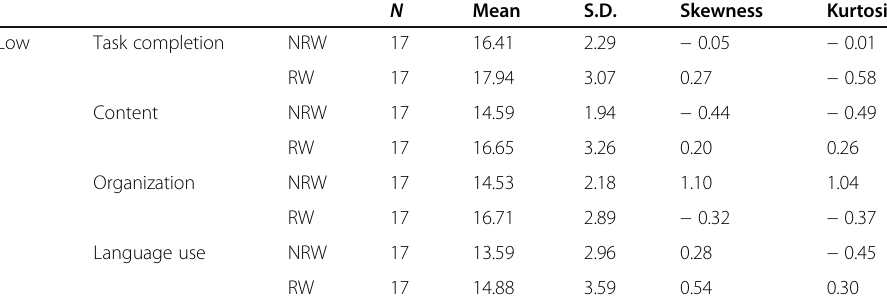
Table 5 Sub-score comparison of the low-proficiency group